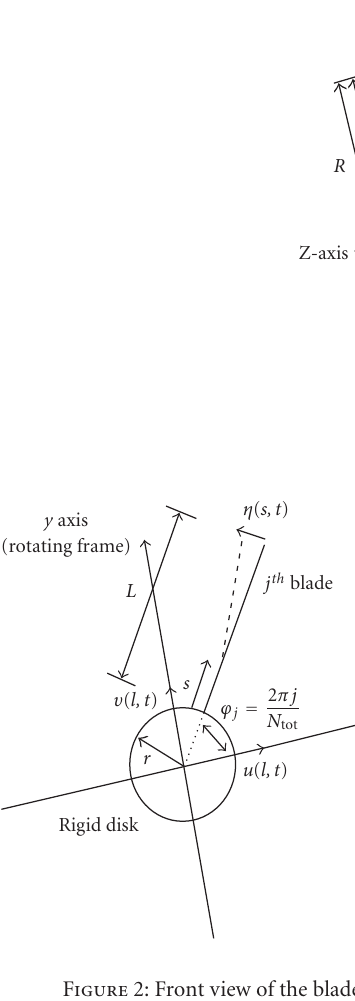
Figure 2: Front view of the bladed